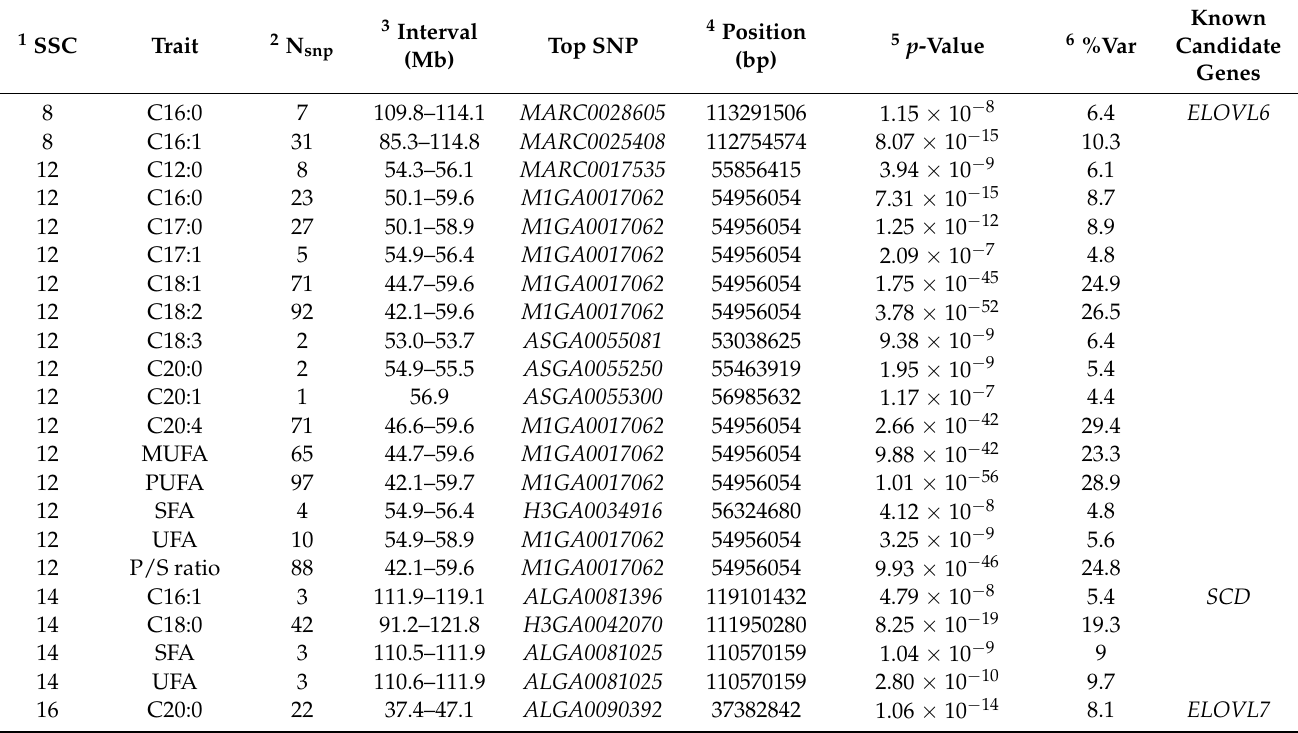
Table 2. Genome-wide significant QTLs for FA traits in an F2 intercross between